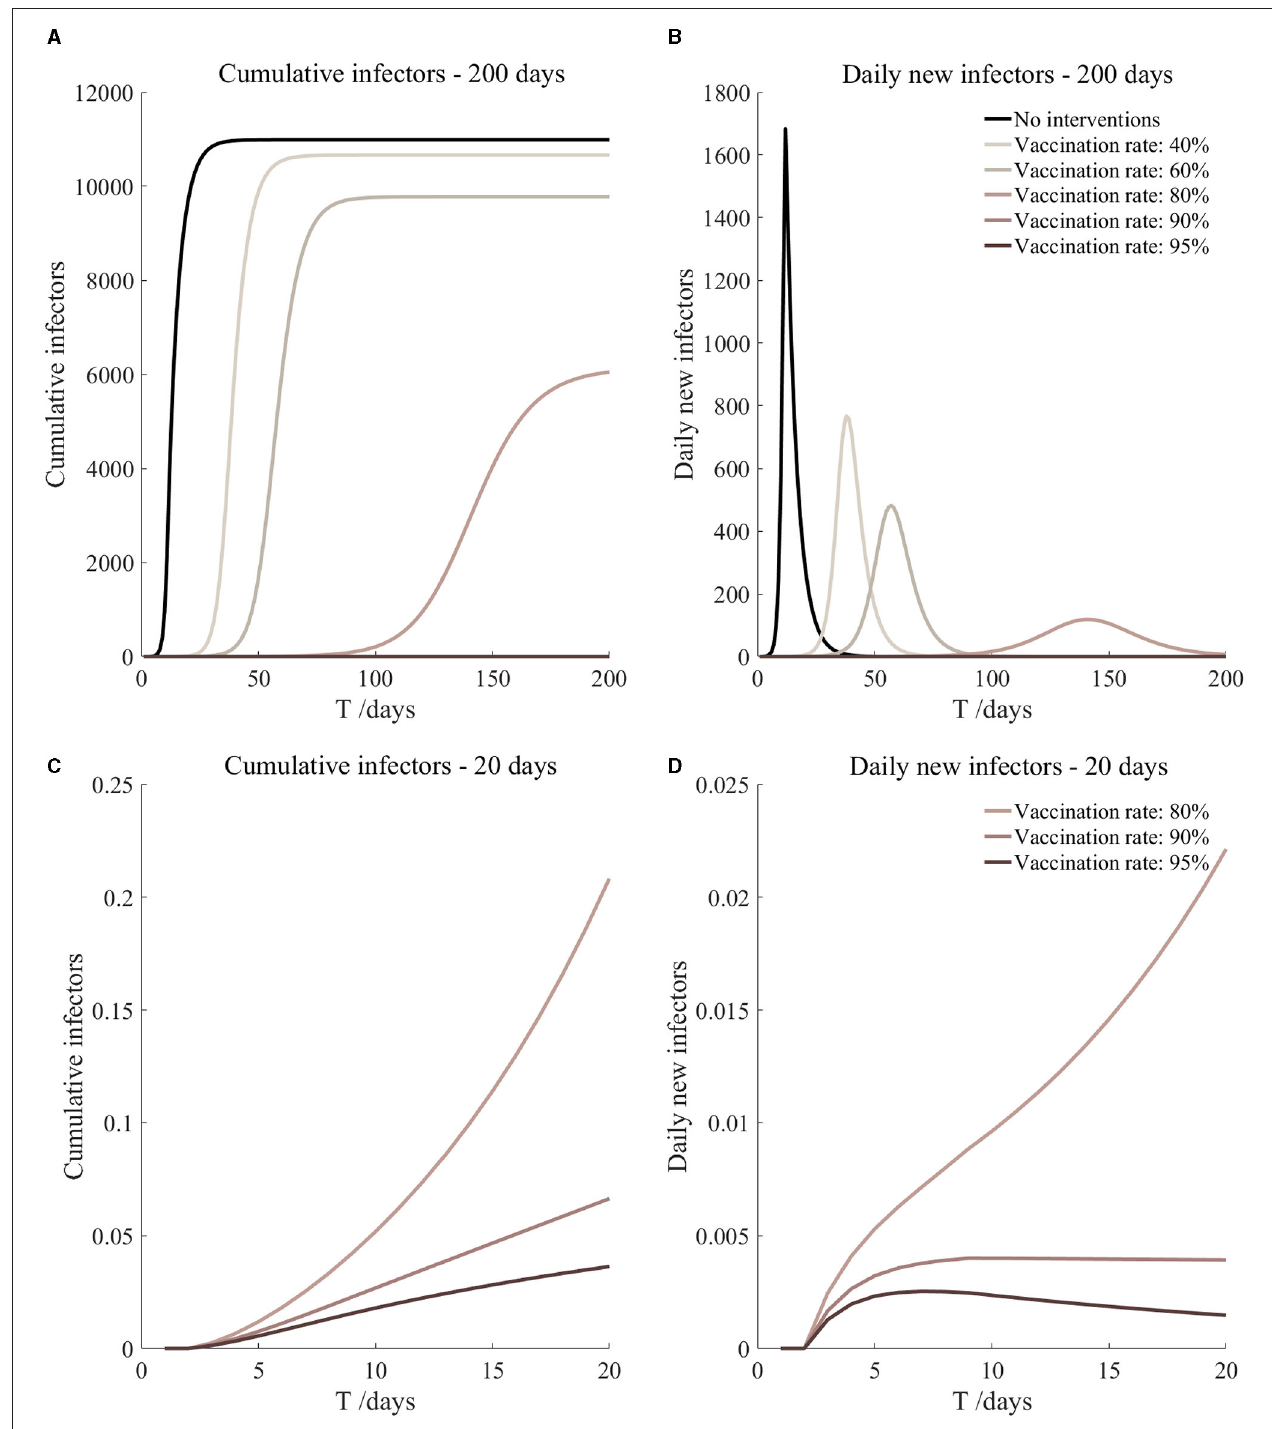
FIGURE 16 | Vaccination and 14-day compulsory quarantine. Assume pre-flight screening can identify 40% of asymptomatic infectors, 14-day compulsory quarantine has about a 4% risk of missed detection.